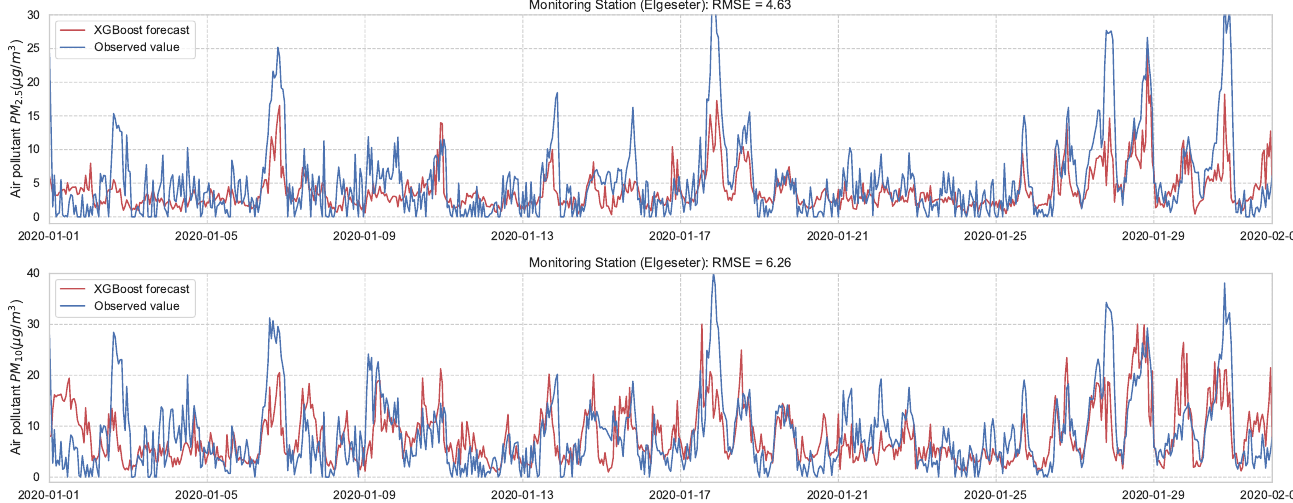
Figure 5. PM-value regression using the XGBoost model over one month in one representative monitoring station. One advantage of using an XGBoost model is the feasibility of retrieving the feature